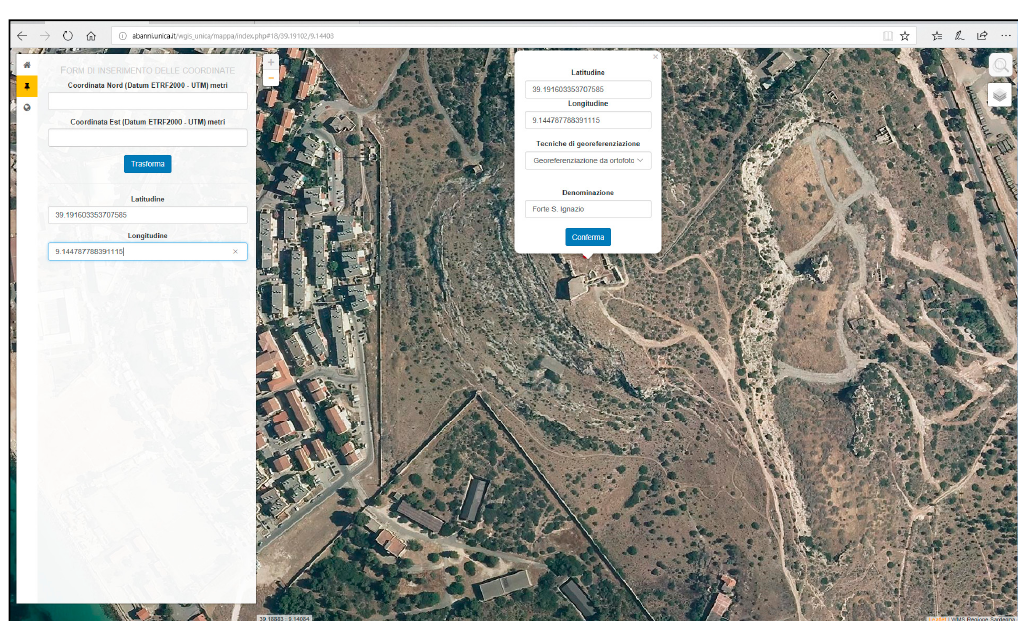
Figure 7. Coordinates input form (S. Ignazio Fort).